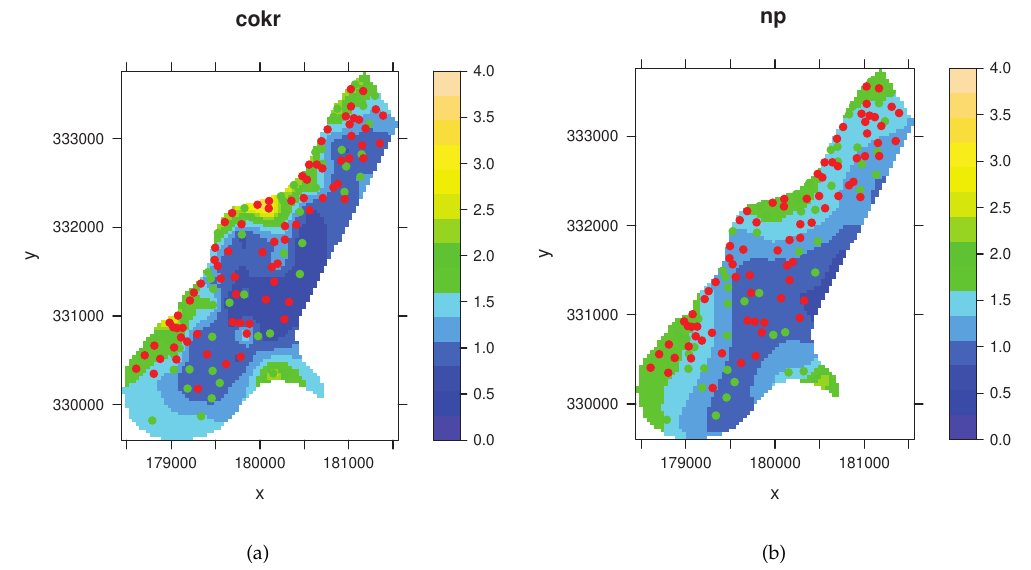
Figure 4. ( a ): Prediction map obtained for the Cd concentrations (in mg/kg soil), with Pb as auxiliary variable, through the universal cokriging. ( b ): Prediction map obtained for the Cd concentrations (in mg/kg soil), with Pb as auxiliary variable, through the nonparametric